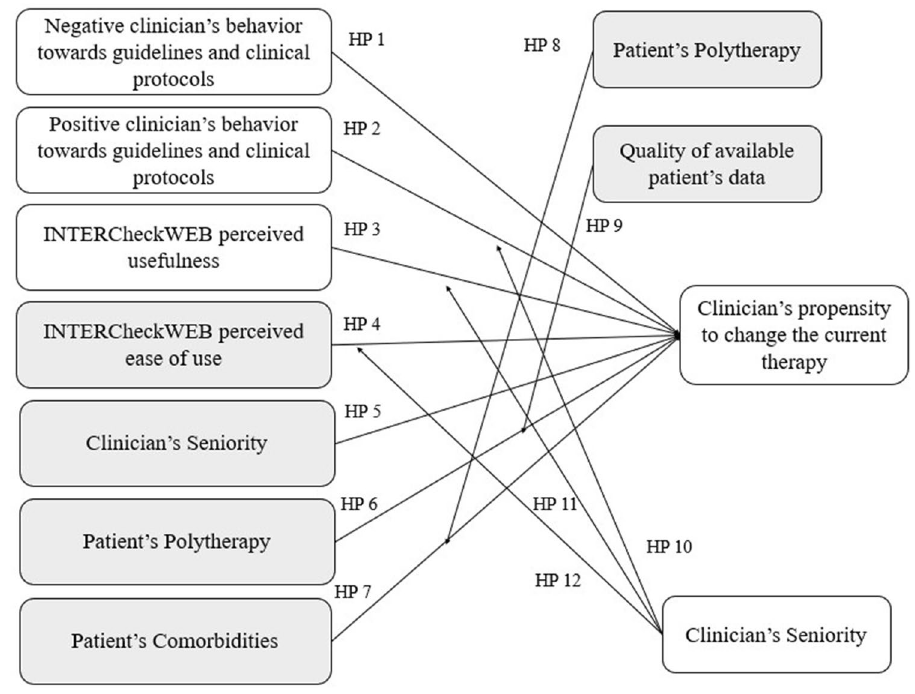
Figure 3. Framework with verified